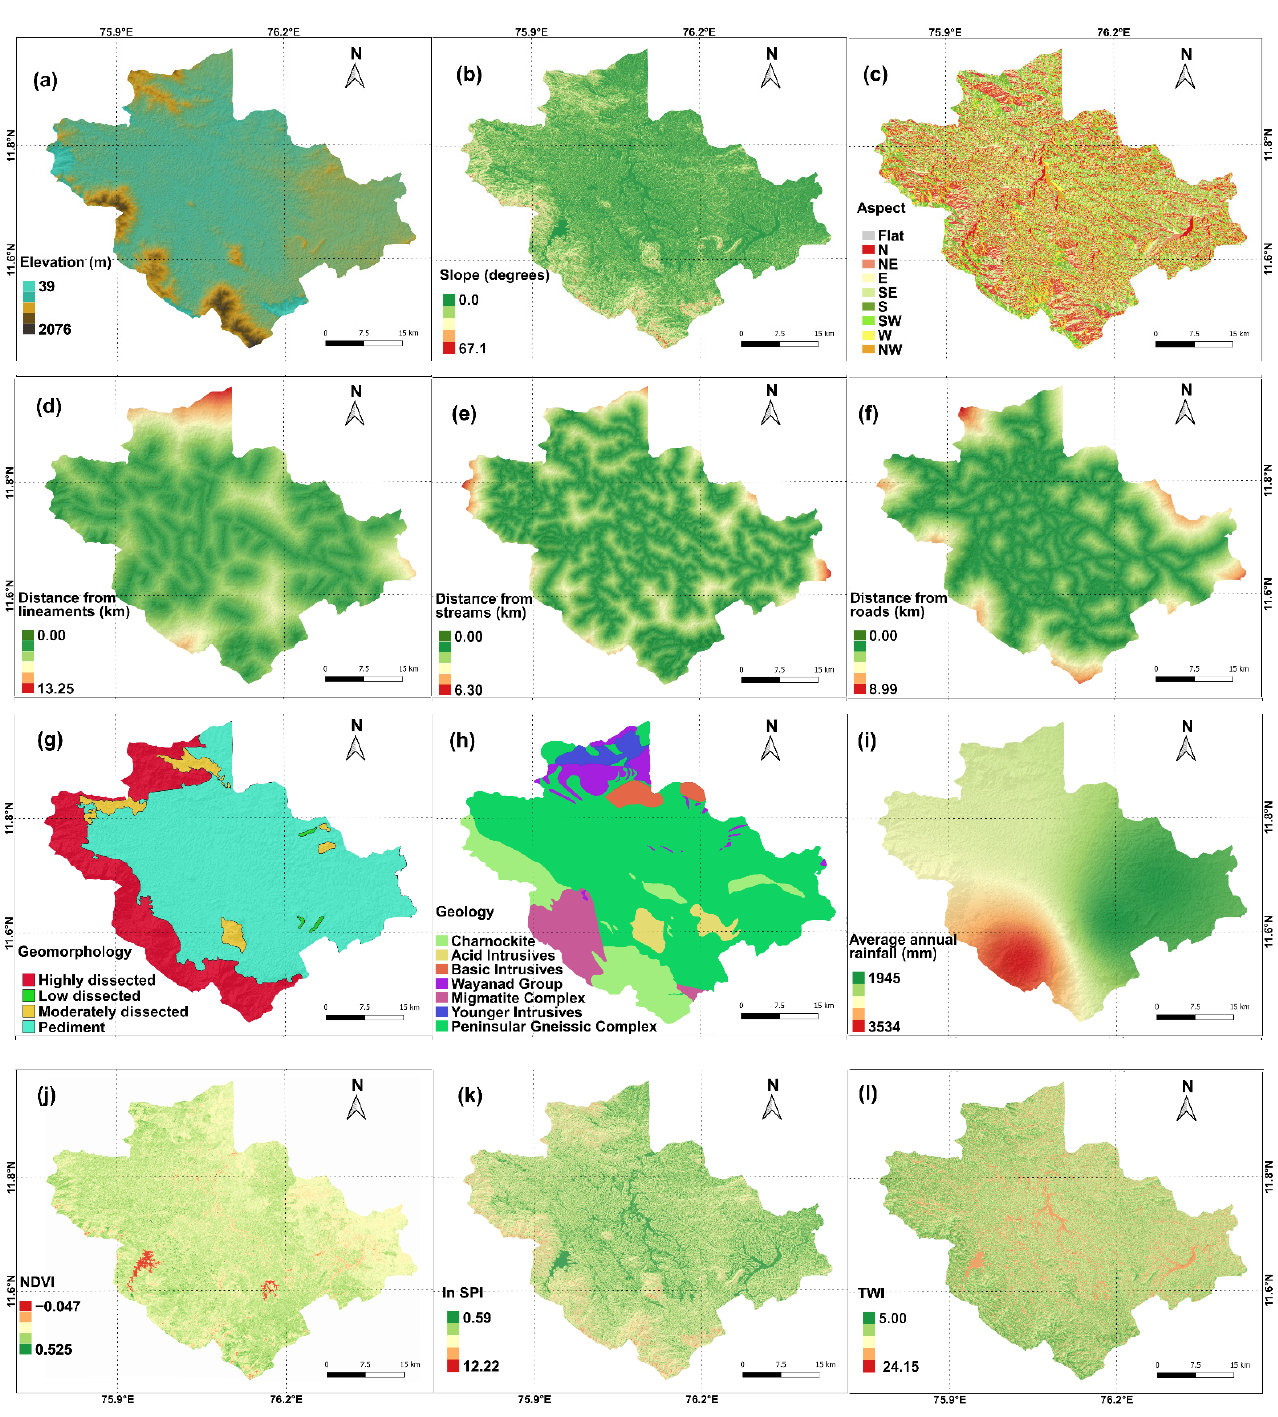
Figure 3. Different LCFs used for LSM: ( a ) elevation, ( b ) slope, ( c ) aspect, ( d ) distance from lineaments, ( e ) distance from streams, ( f ) distance from roads, ( g ) geomorphology, ( h ) geology, ( i ) rainfall, ( j ) NDVI, ( k ) ln SPII, and ( l ) TWI.